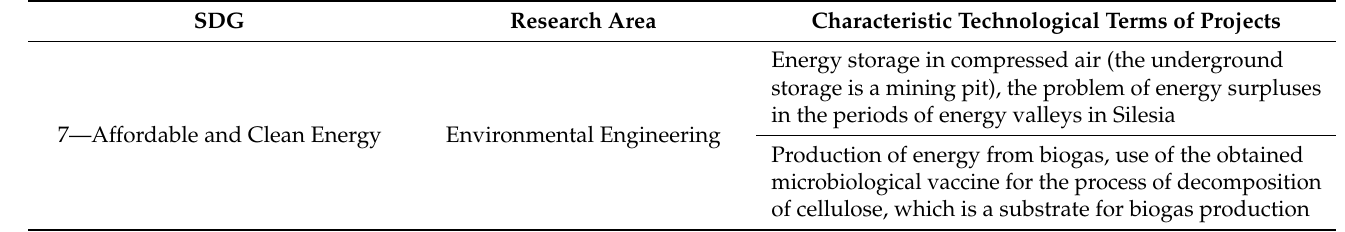
Table 12. Characteristic technological terms of projects for Affordable and Clean Energy.